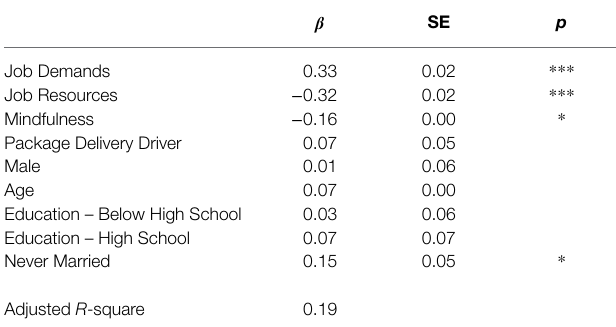
TABLE 3 | Regression analysis of burnout.